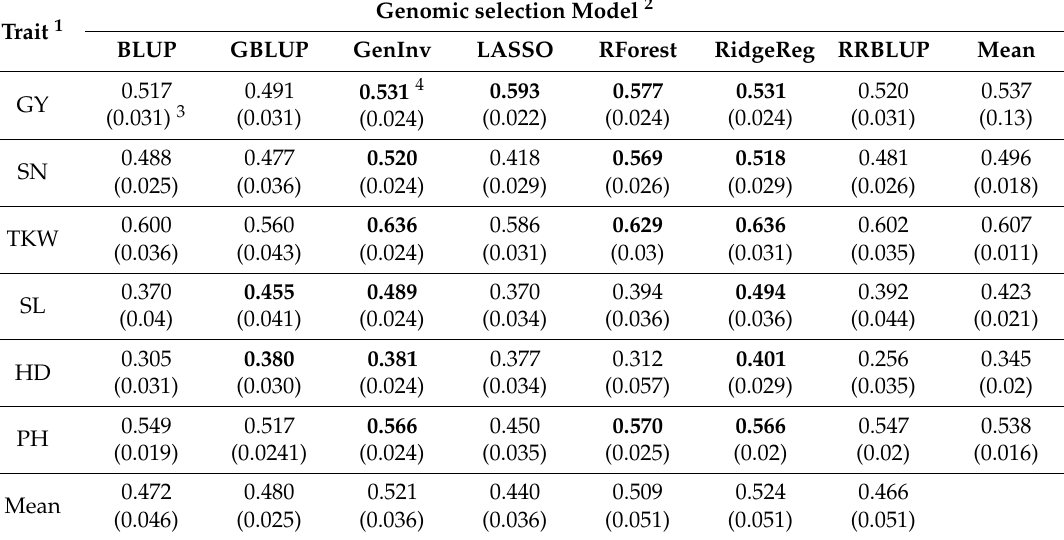
Table 4. Prediction accuracies of yield and yield-related traits for the seven GS models using imputed markers. The QC to keep markers with missing rate levels < 40% and minor allele frequency (MAF) > 5% was used as an